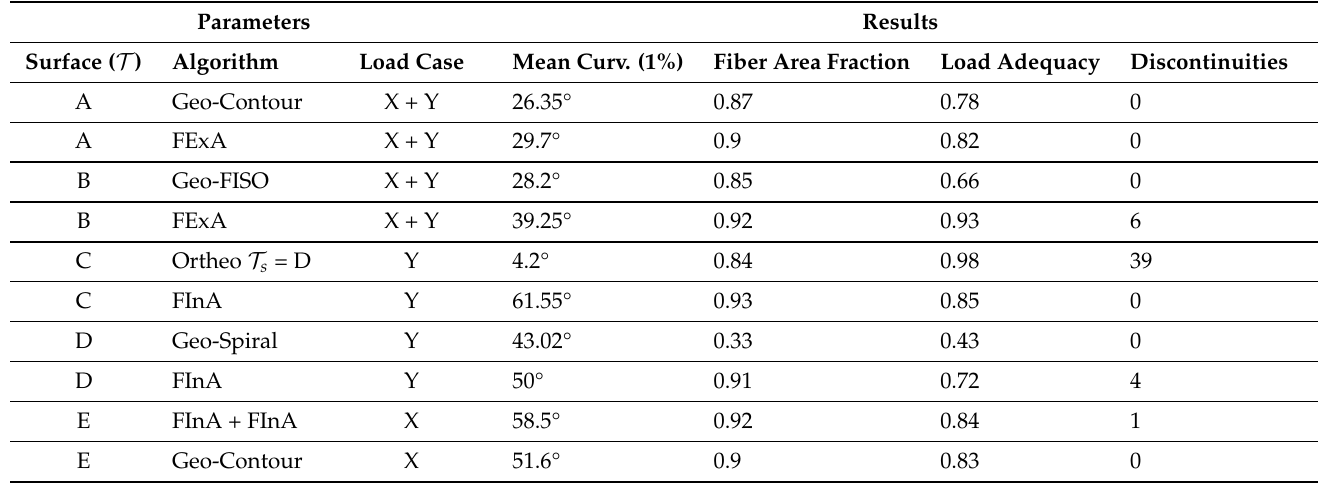
Table 1. Evaluation criteria for the chosen combinations of surface and algorithm 1